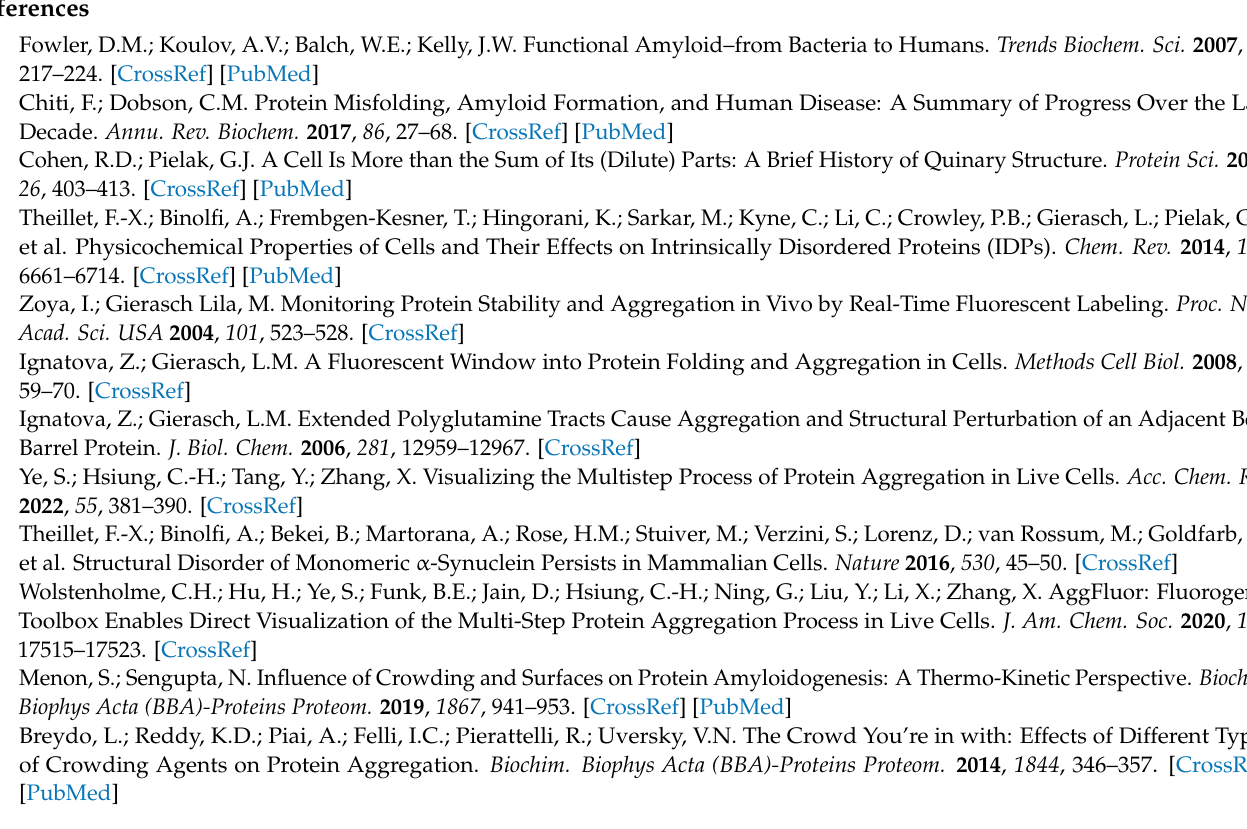
Table S2: Table 2 organized by